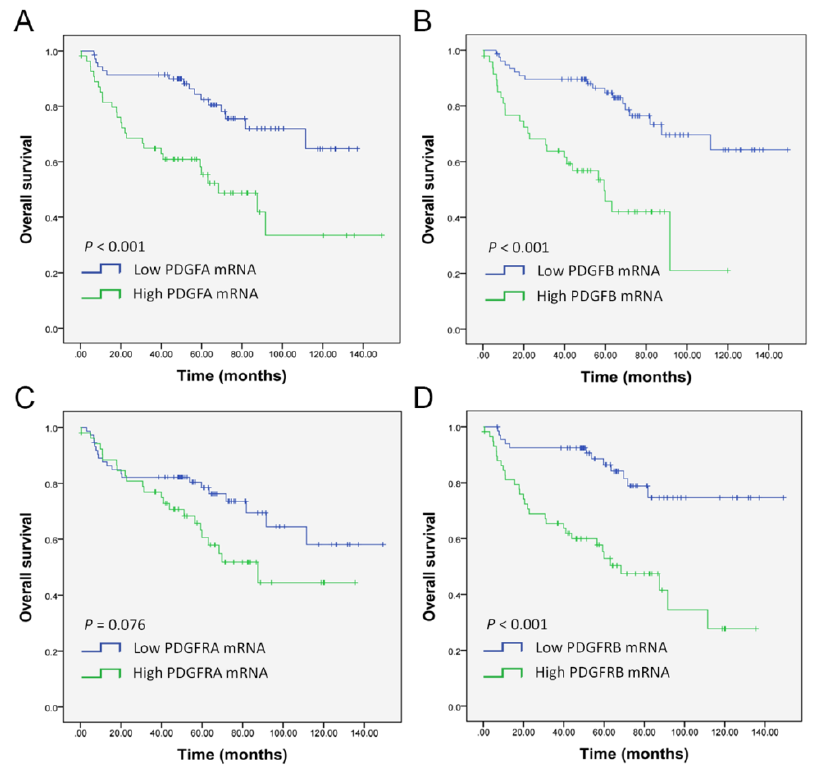
Figure 4. Kaplan–Meier analysis for overall patient survival according to mRNA expression of ( A ) PDGFA, ( B ) PDGFB, ( C ) PDGFRA, and ( D ) PDGFRB in OSCC. p -values were calculated by the log-rank test.